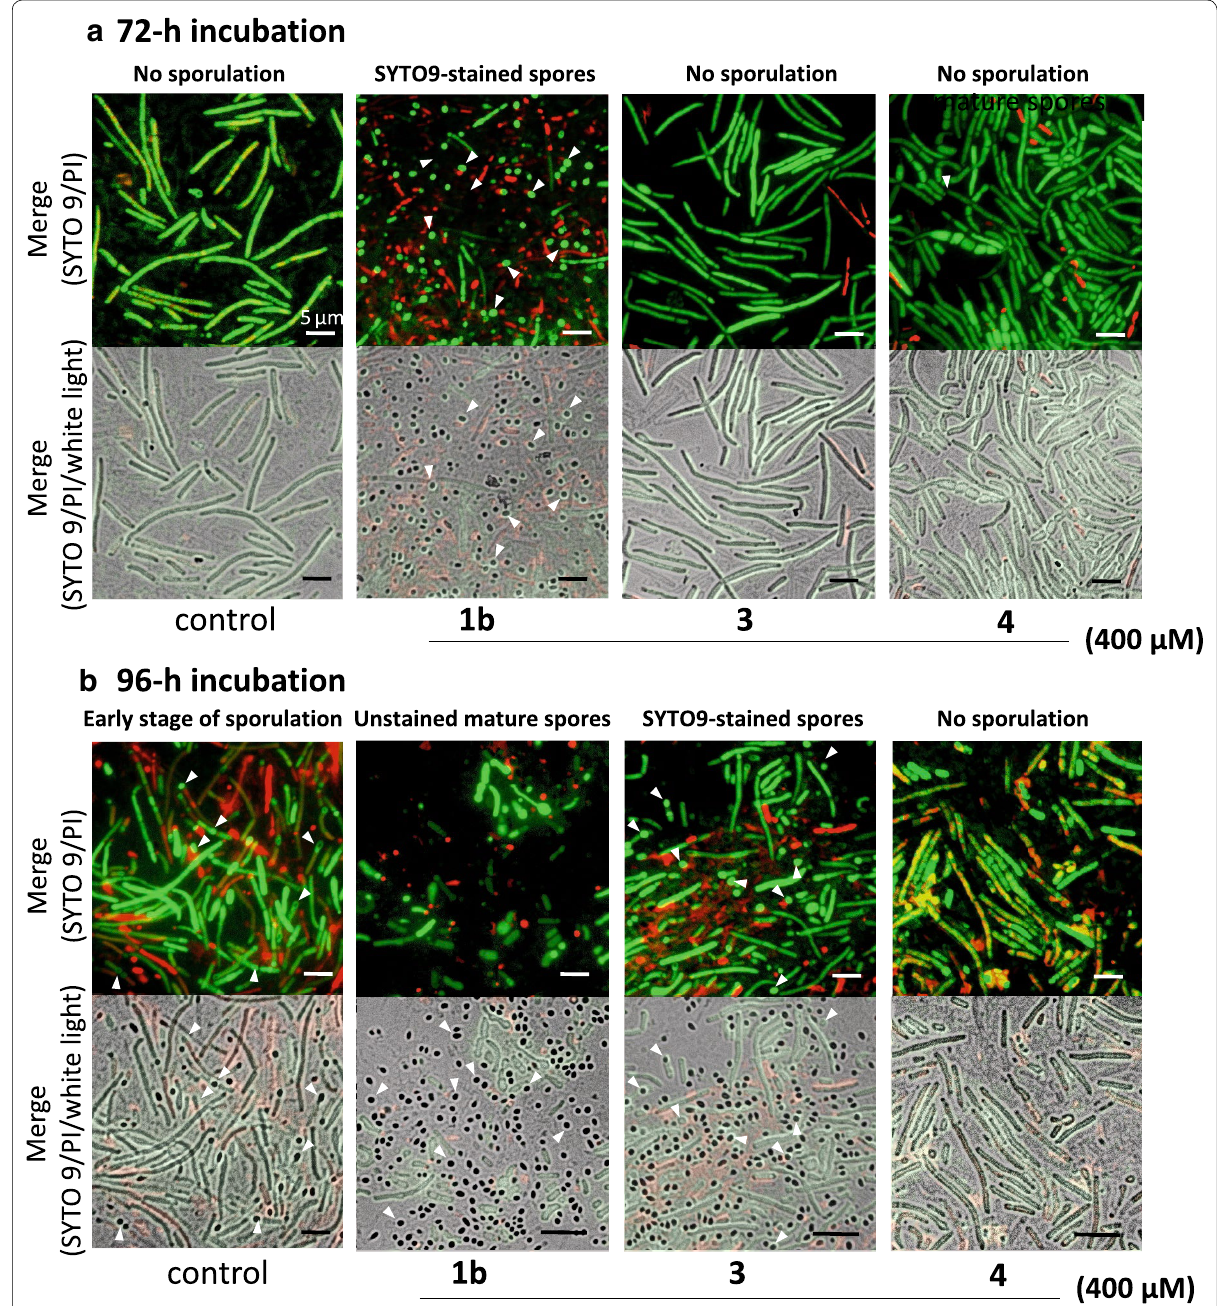
Fig. 6 Comparison of sporulation-inducing activities of diacetonamine hydrochloride (1b) and diacetone acrylamide (3) toward B. megaterium. For the sporulation induction assay using B. megaterium NBRC 15308, SIF-like activities of the test compounds ( 1b , 3 , and 4 ) were examined at 400 µM. a Sporulation induction to B. megaterium vegetative cells at 72-h incubation. b Sporulation induction at 96-h incubation. Arrowheads show typical spores abundant in each bacterial cell culture. Scale bar 5 =